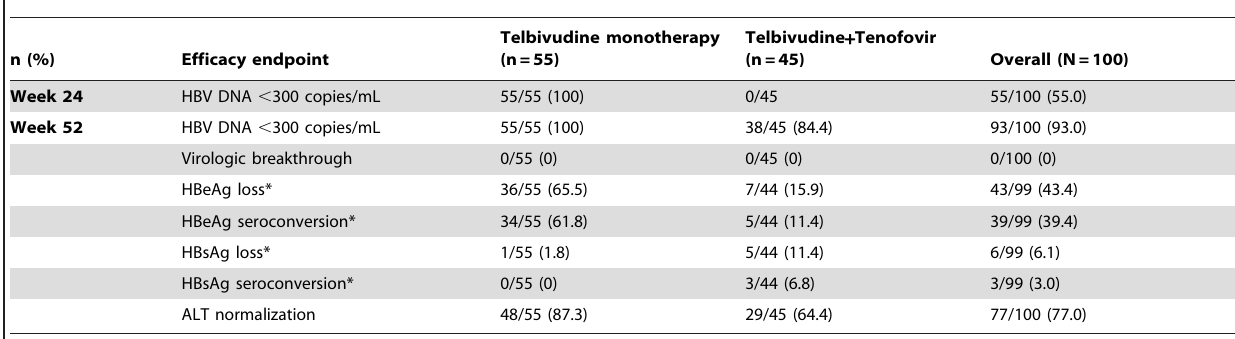
Table 2. Results of efficacy endpoints up to Week 52 (efficacy population, LOCF).